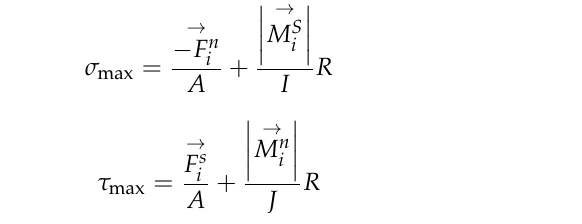
  s n F F and are, respectively, the normal force and i i   n s M M and are, respectively, the normal moment i i